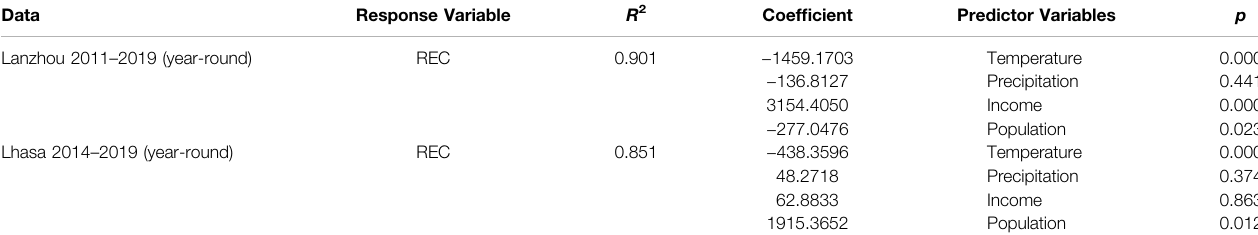
TABLE 1 | Results of ordinary least squares (OLS) linear regression modeling of the Lanzhou and Lhasa year-round datasets. (REC - residential electricity consumption). Data